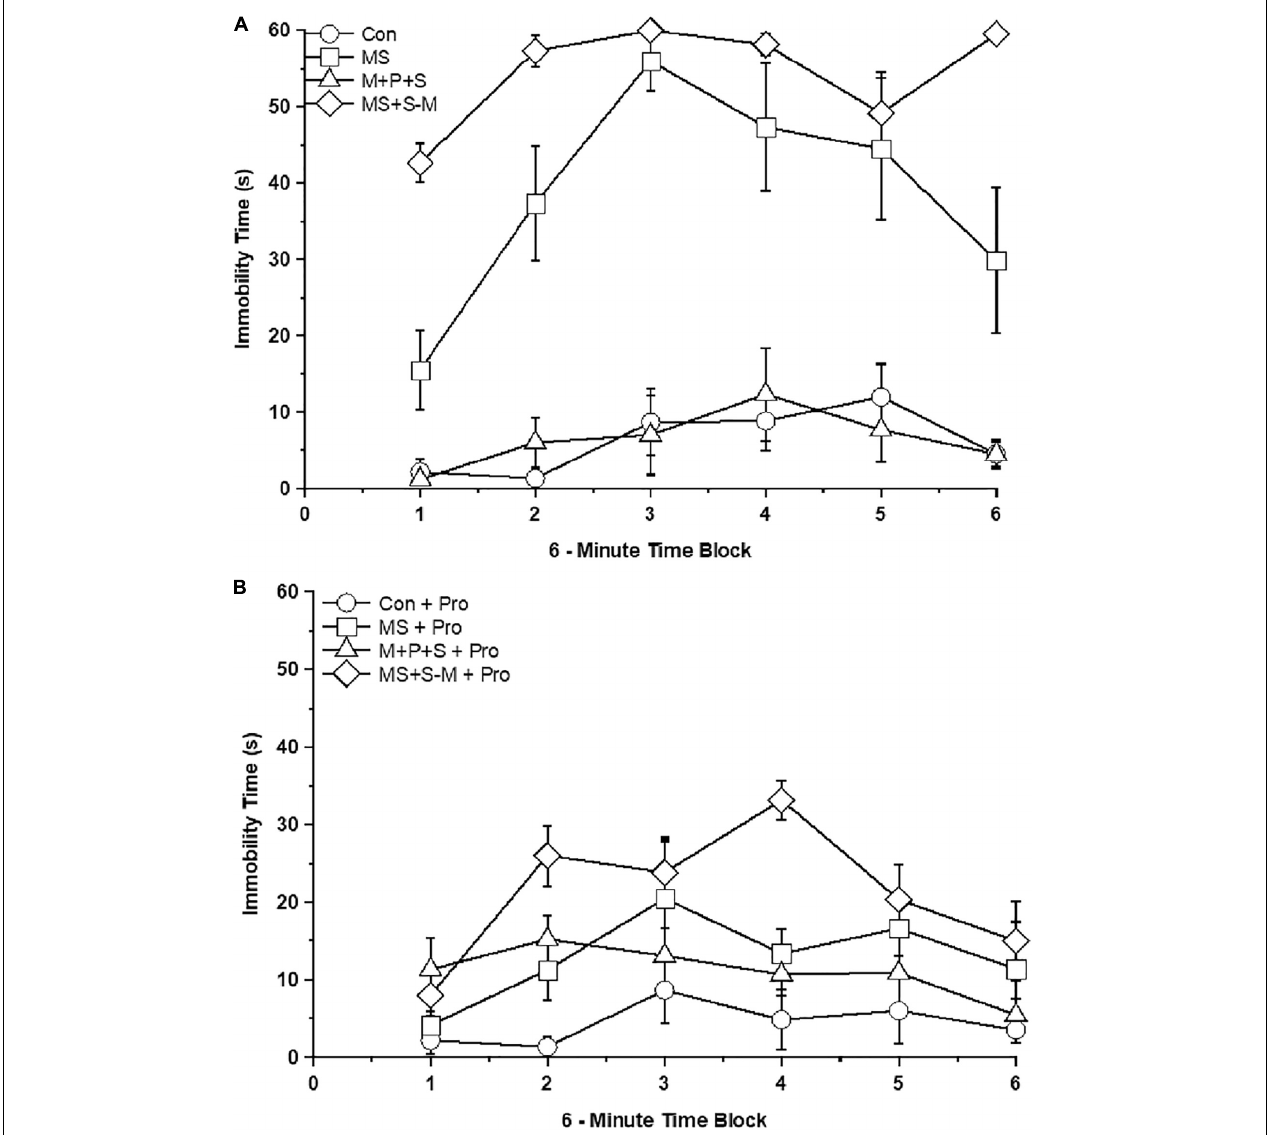
FIGURE 4 | Tail suspension test in the stressed group or stressed group supplemented with probiotics. The duration of immobility was longer in the stressed groups compared to the control group and the stressed group supplemented with probiotics. Values are presented as mean ± SEM. (A) Early-life SSE induced immobilization and labels are indicated as ◦ – con; (cid:3) – MS; (cid:49) - M+P+S; (cid:5) - MS+S-M. (B) Supplementation of Lactobacillus significantly prevented the early-life SSE induced immobilization and labels are indicated as ◦ – con + Pro; (cid:3) – MS + Pro; (cid:49) - M + P + S + Pro; (cid:5) - MS + S-M + Pro.